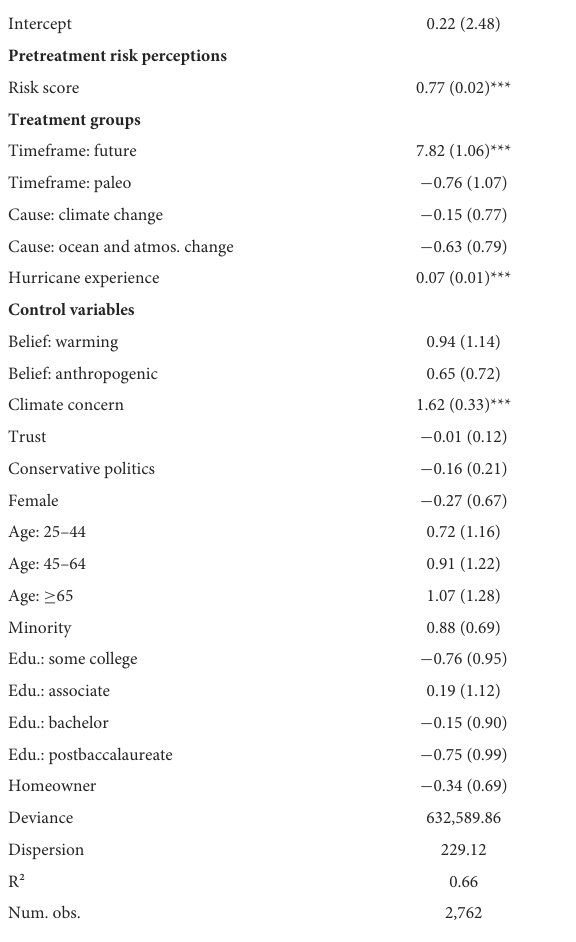
TABLE 3 Linear regression, post-treatment risk